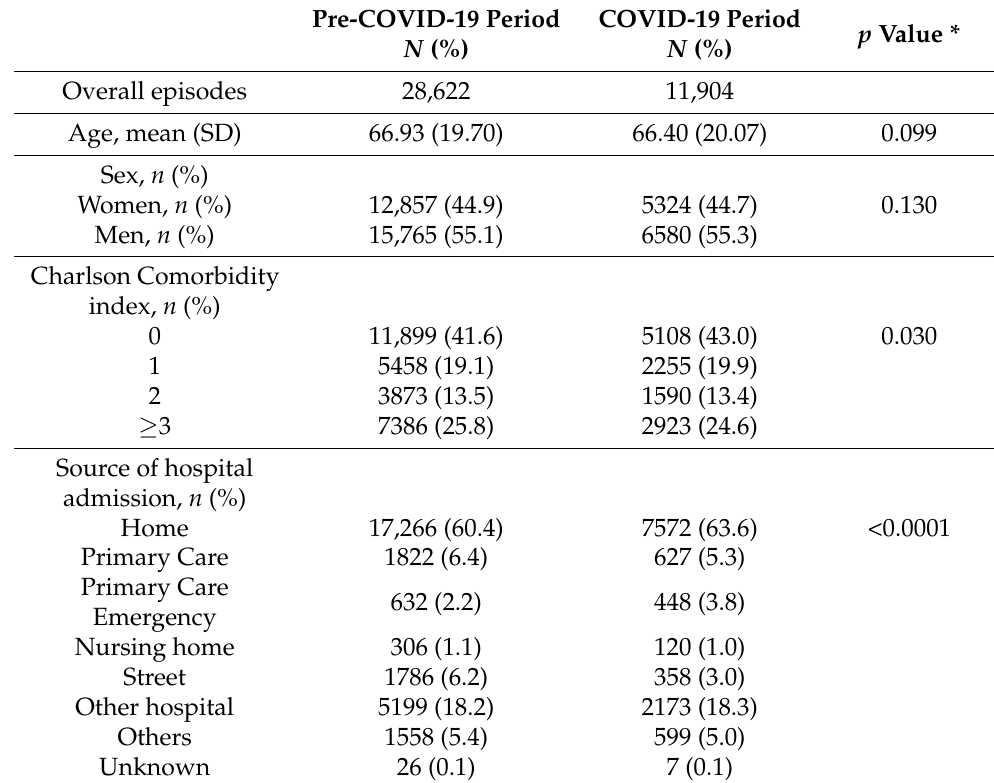
Figure 1. Weekly hospital admissions during the pre-COVID period (March 2018–February 2020) and COVID period (March 2020–February 2021). Weekly admissions of COVID-19 cases are displayed for comparison. Table 1. Baseline sociodemographic and clinical characteristics of non-COVID patients and compari- son between COVID and Pre-COVID periods. Pre-COVID-19 period: March 2018 to February 2020; COVID-19: March 2020 to February 2021. SD: standard deviation. * p -values express the presence of statistically significant differences between the two periods ( t -test for continuous variables, chi-square test for